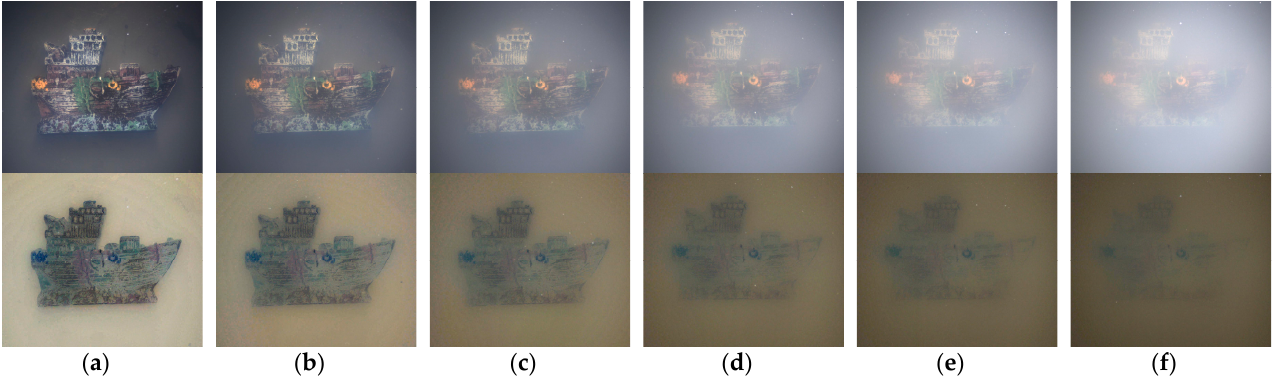
Figure 13. Image I and DOP at different turbidities: ( a ) 0.3 mL/L; ( b ) 0.6 mL/L; ( c ) 0.9 mL/L; ( d ) 1.2 mL/L; ( e ) 1.5 mL/L; ( f ) 1.8 mL/L.